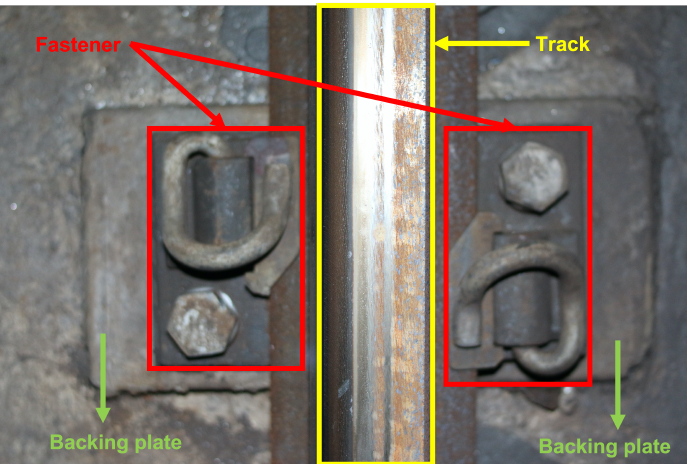
Figure 1. The railway track line structure of Beijing Metro Line